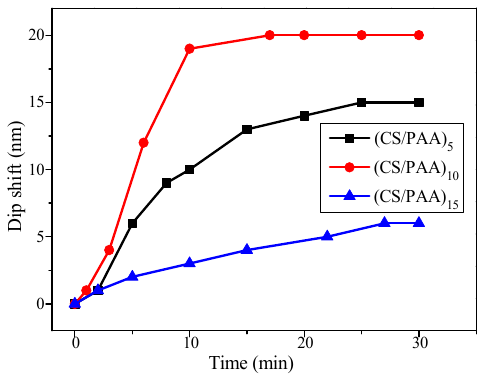
Figure 8. Comparison of wavelength shifts for SPR sensors with different numbers of layers of sensitive film.